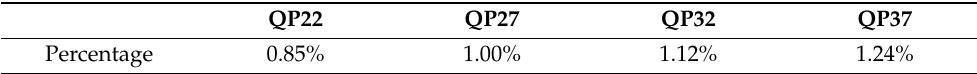
Table 7. Inference overhead compared with the original HM16.7 encoding